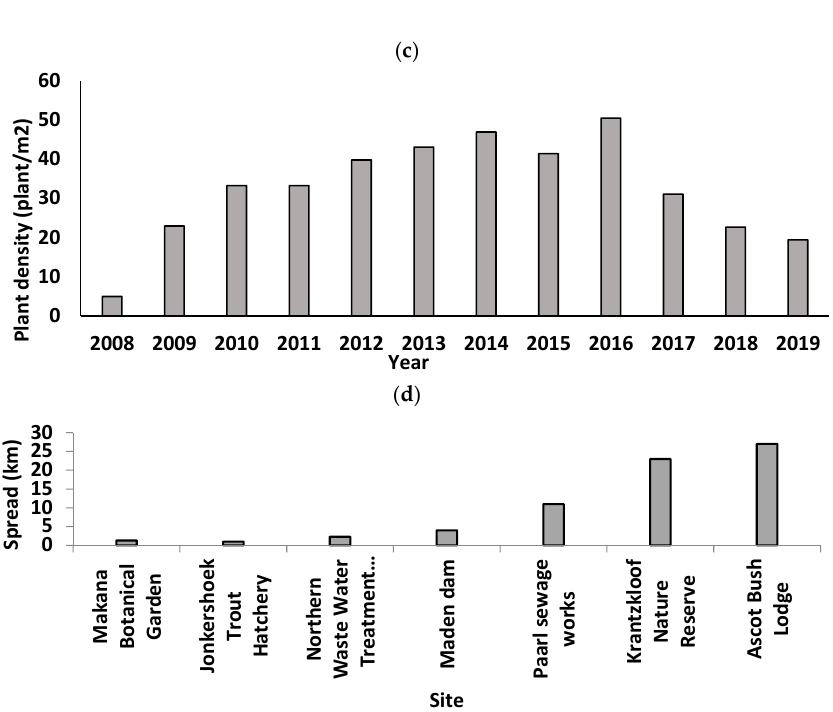
Figure 2. ( a ) Significant increase in cumulative number of Sagittaria platyphylla sites recorded per year in South Africa (GLM; F 1, 10 = 0.222, P = 0.001). ( b ) Significant increase in mean population size of S. platyphylla per year in South Africa (GLM.NB; F 1, 10 = 0.109, P = 0.003). ( c ) Mean plant density of S. platyphylla per year in South Africa (GLM.NB; F 1, 10 = 0.028, P = 0.476). ( d ) The spread (km) of S. platyphylla from the most invaded populations since 2008.